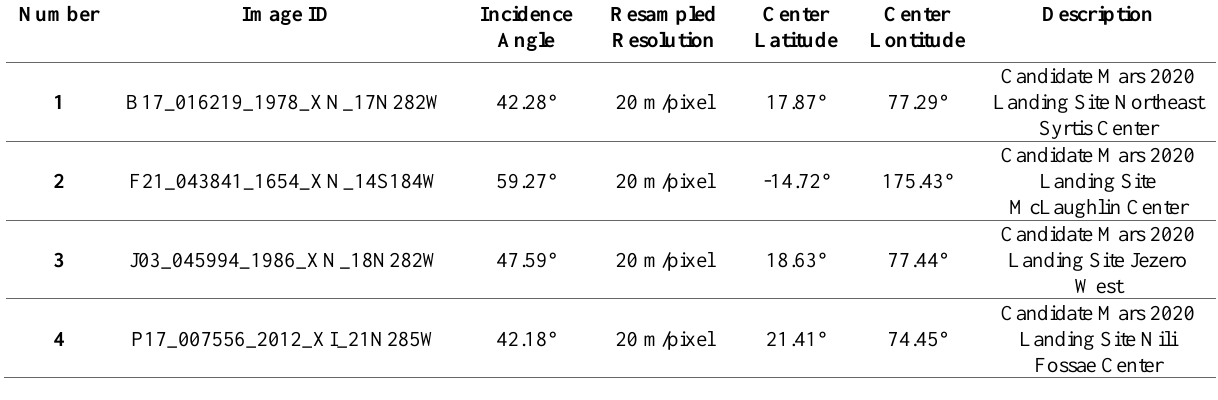
Table 1. Information of the CTX images used for validation